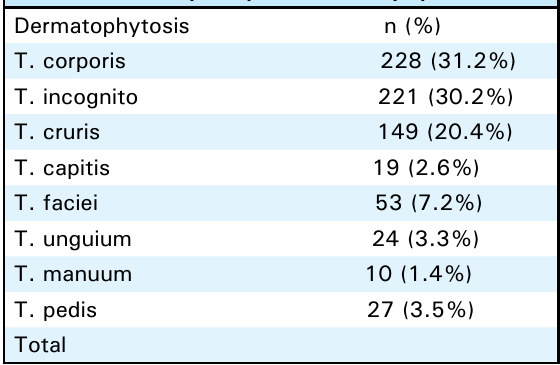
Table 1. The frequency* of dermatophytosis.